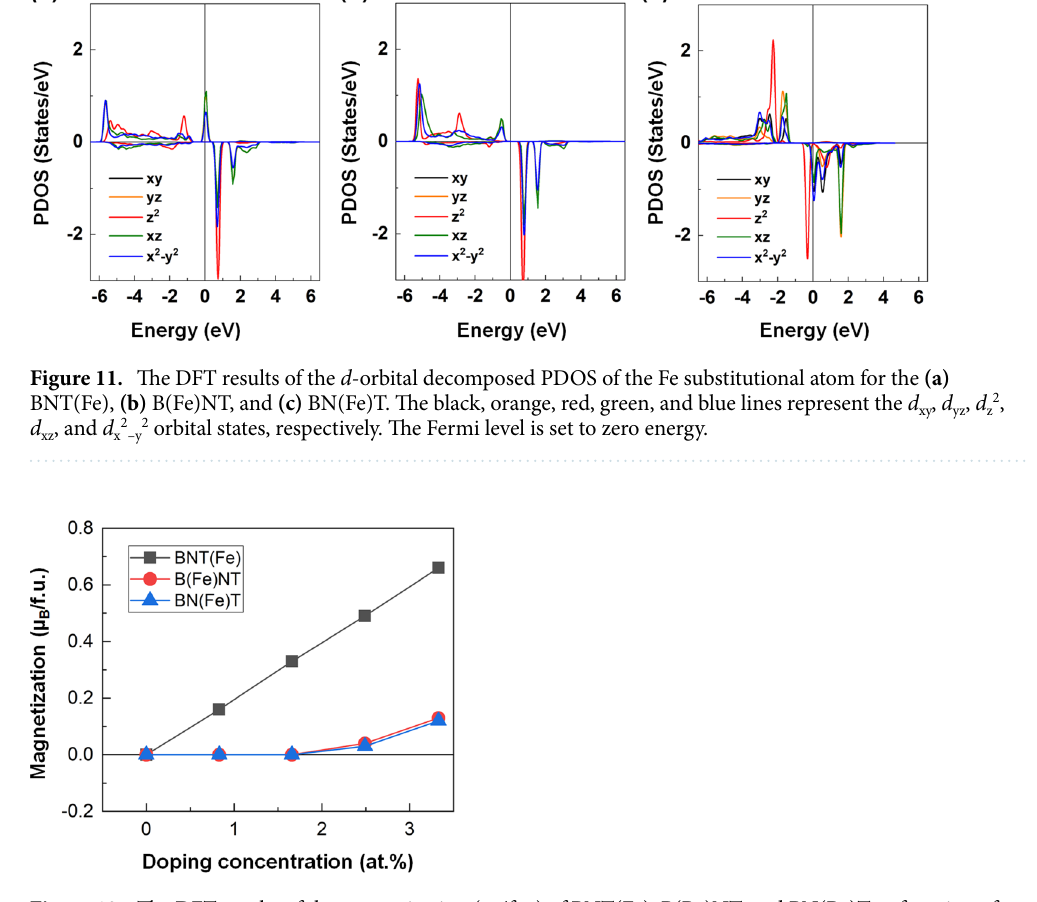
Figure 12. The DFT results of the magnetization (µ B /f.u.) of BNT(Fe), B(Ba)NT, and BN(Ba)T as function of the concentration of the dopant